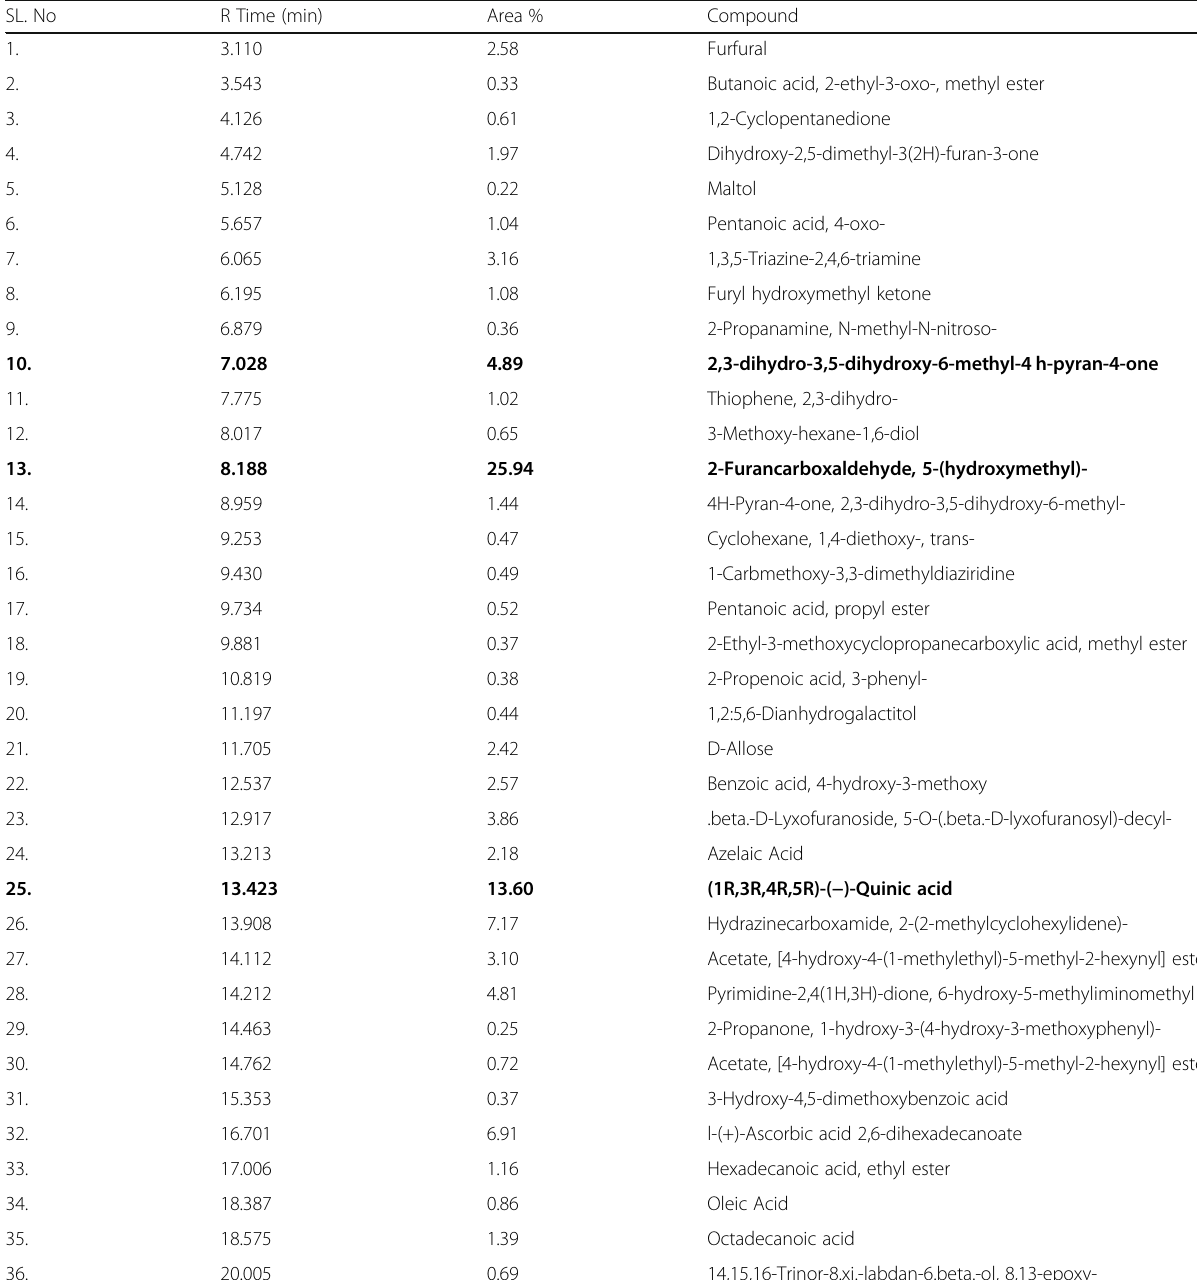
Table 1 Chemical composition of Gardenia gummifera L.f. fruit extract SL. No R Time (min) Area %